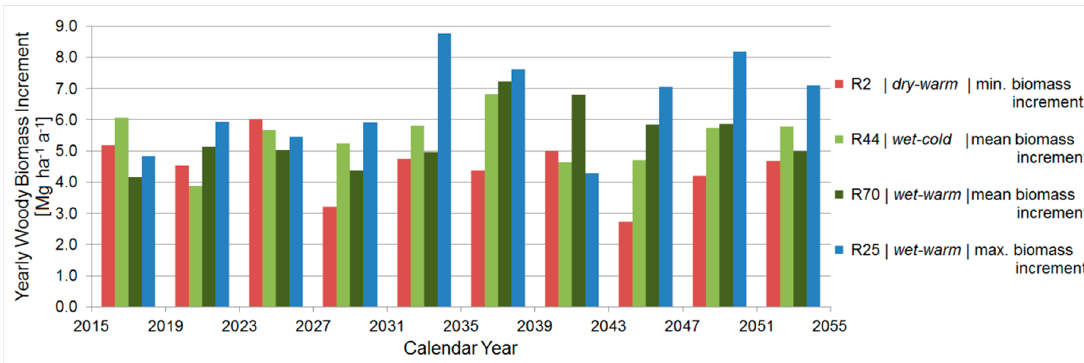
Figure 8. Projected minimum (orange), mean (green), and maximum (blue) yearly woody biomass increment of poplar trees with respect to the ten established growing periods.